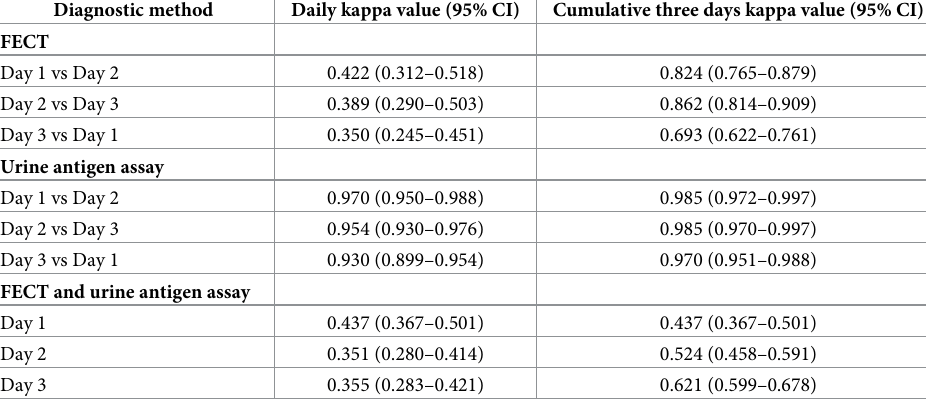
Table 3. Diagnostic agreement (kappa value) for detection of O . viverrini infection between FECT and urine assay per day and cumulatively over three consecutive